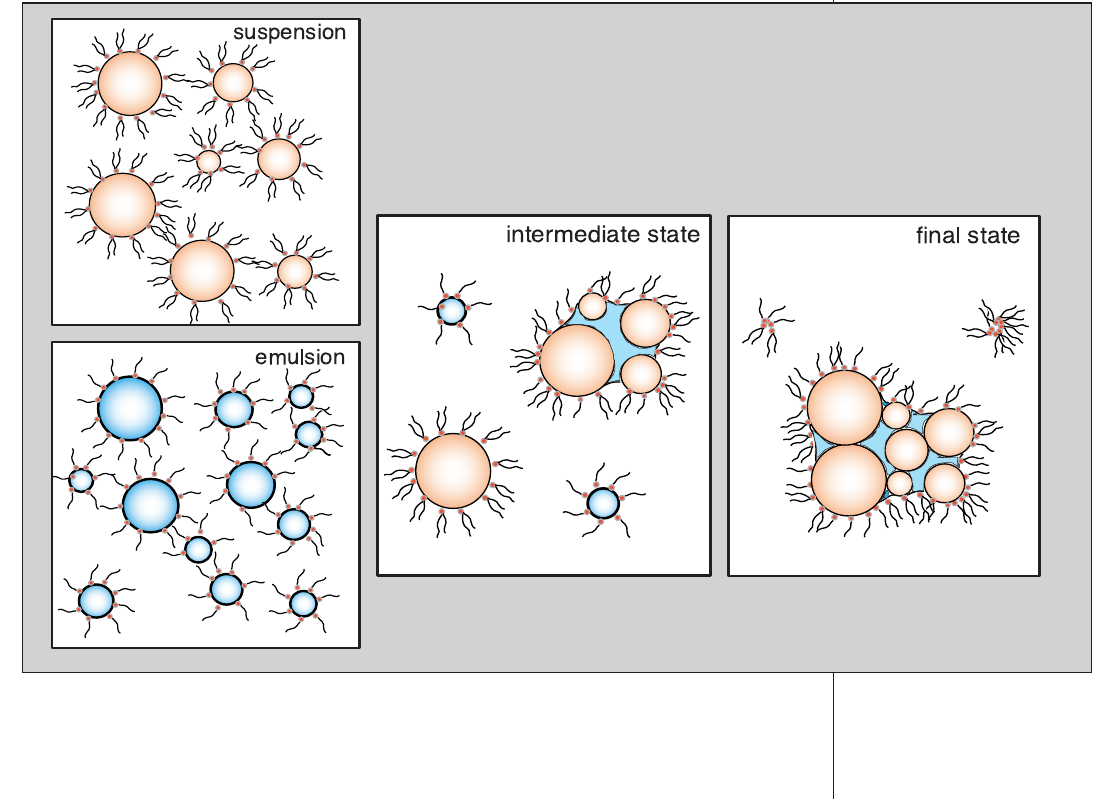
Figure 9: Structural model of mixtures from suspensions and